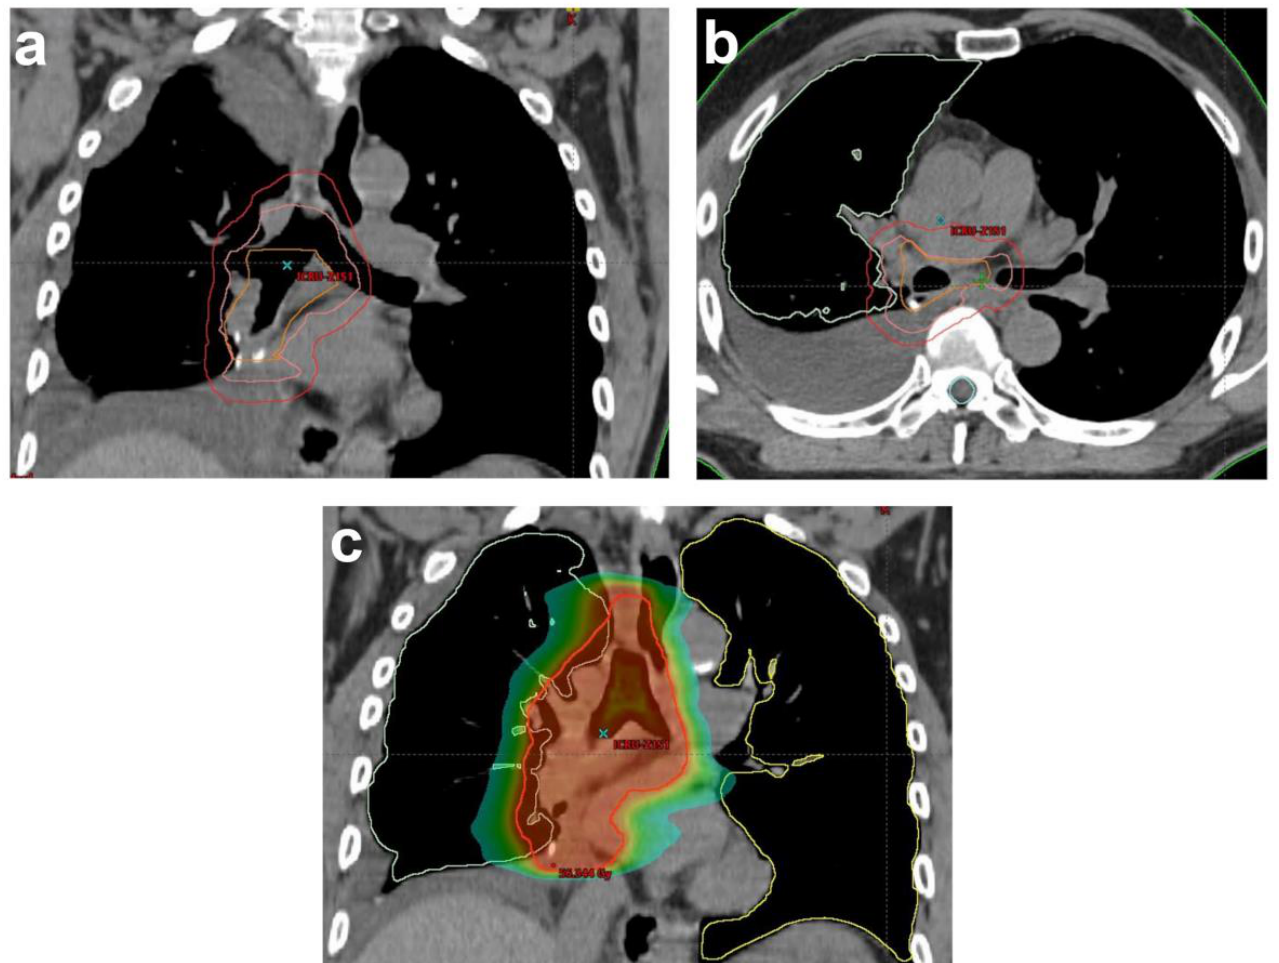
Figure 1. Illustration of RT planning of PORT for a completely resected NSCLC patient with histologi- cally proven lymph nodes (2/9) in stations 7 and 10R in ( a ) coronal and ( b ) sagittal views. Delineation based on the Lung ART protocol of rCTV (orange): bronchial stump, ipsilateral hilar node region (10R) and lymph node station 7. CTV (pink): rCTV+1 cm. In this case, 4R, 7 and 10R had a maximal upper limit to the top of the aortic arc and a maximal lower limit 5 cm below the carina. PTV (red); ( c ) color wash of dose distribution ranging from 20 Gy to 57.7 Gy (prescribed dose: 54 Gy). rCTV: resected clinical tumor volume, CTV: clinical tumor volume, PTV: planning target